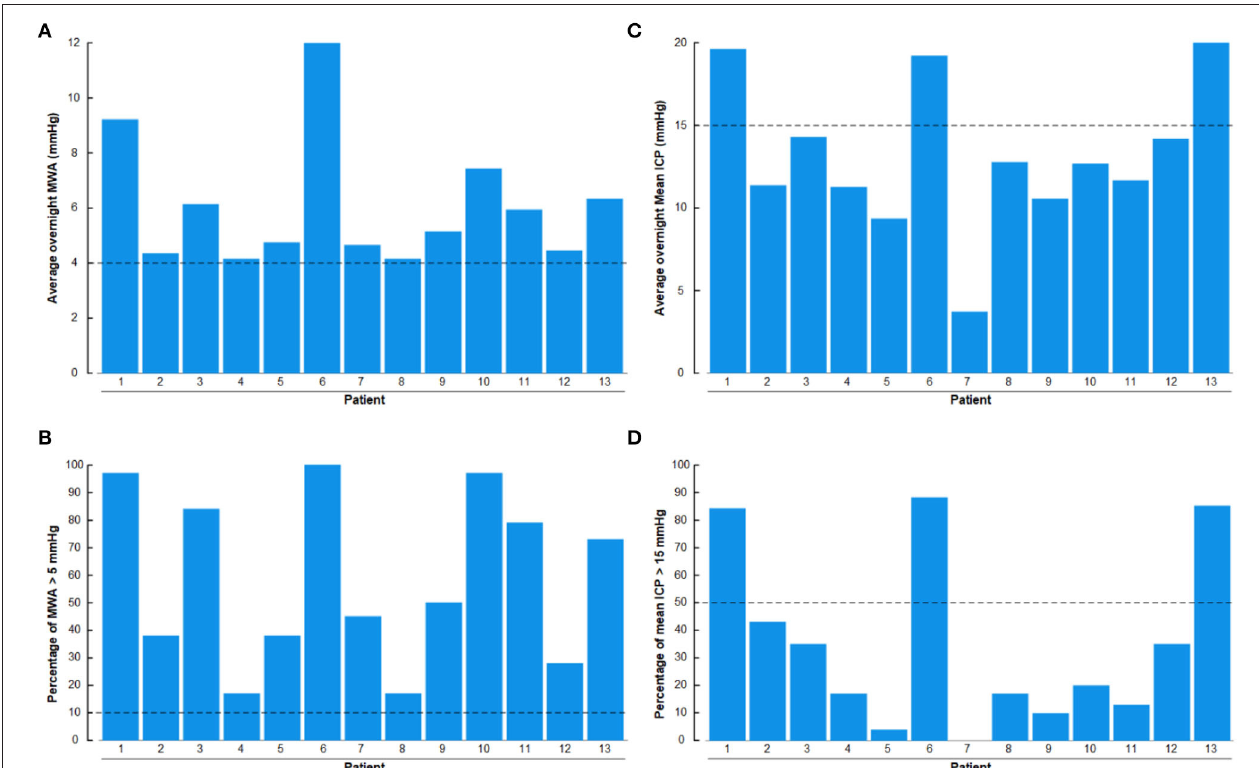
FIGURE 11 | The overnight recordings of MWA and mean ICP in the 13 Patients with IIH included in the study are shown on an individual basis. (A) Overnight average of MWA. (B) Overnight percentage of MWA > 5 mmHg. (C) Overnight average of mean ICP. (D) Overnight percentage of mean ICP > 15 mmHg. The horizontal lines indicate upper normal thresholds as defined by the first author: (A) Overnight MWA > 4 mmHg. (B) Overnight 10% of MWA > 5 mmHg. (C) Overnight Mean ICP > 15 mmHg. (D) Overnight 50% of Mean ICP > 15